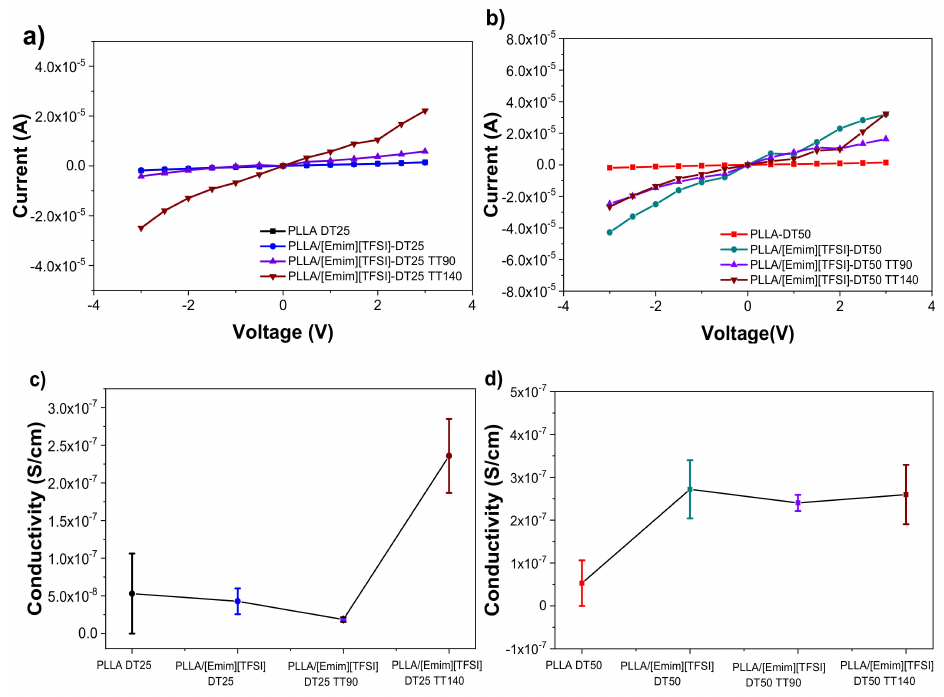
Figure 8. IV curves ( a , b ) and electrical conductivity ( c , d ) as a function of the post-thermal treatment temperature of the PLLA-based films dried at 25 ◦ C (left column) and 50 ◦ C (right